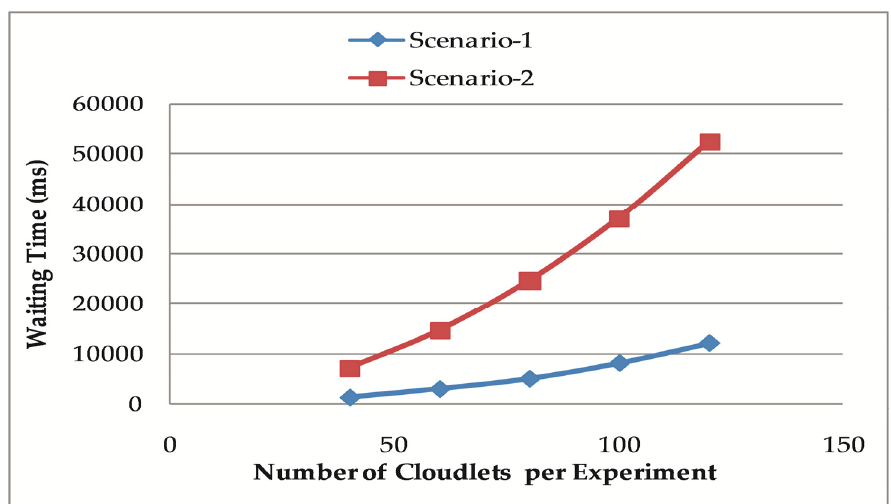
Figure 7. Waiting time versus number of cloudlets.